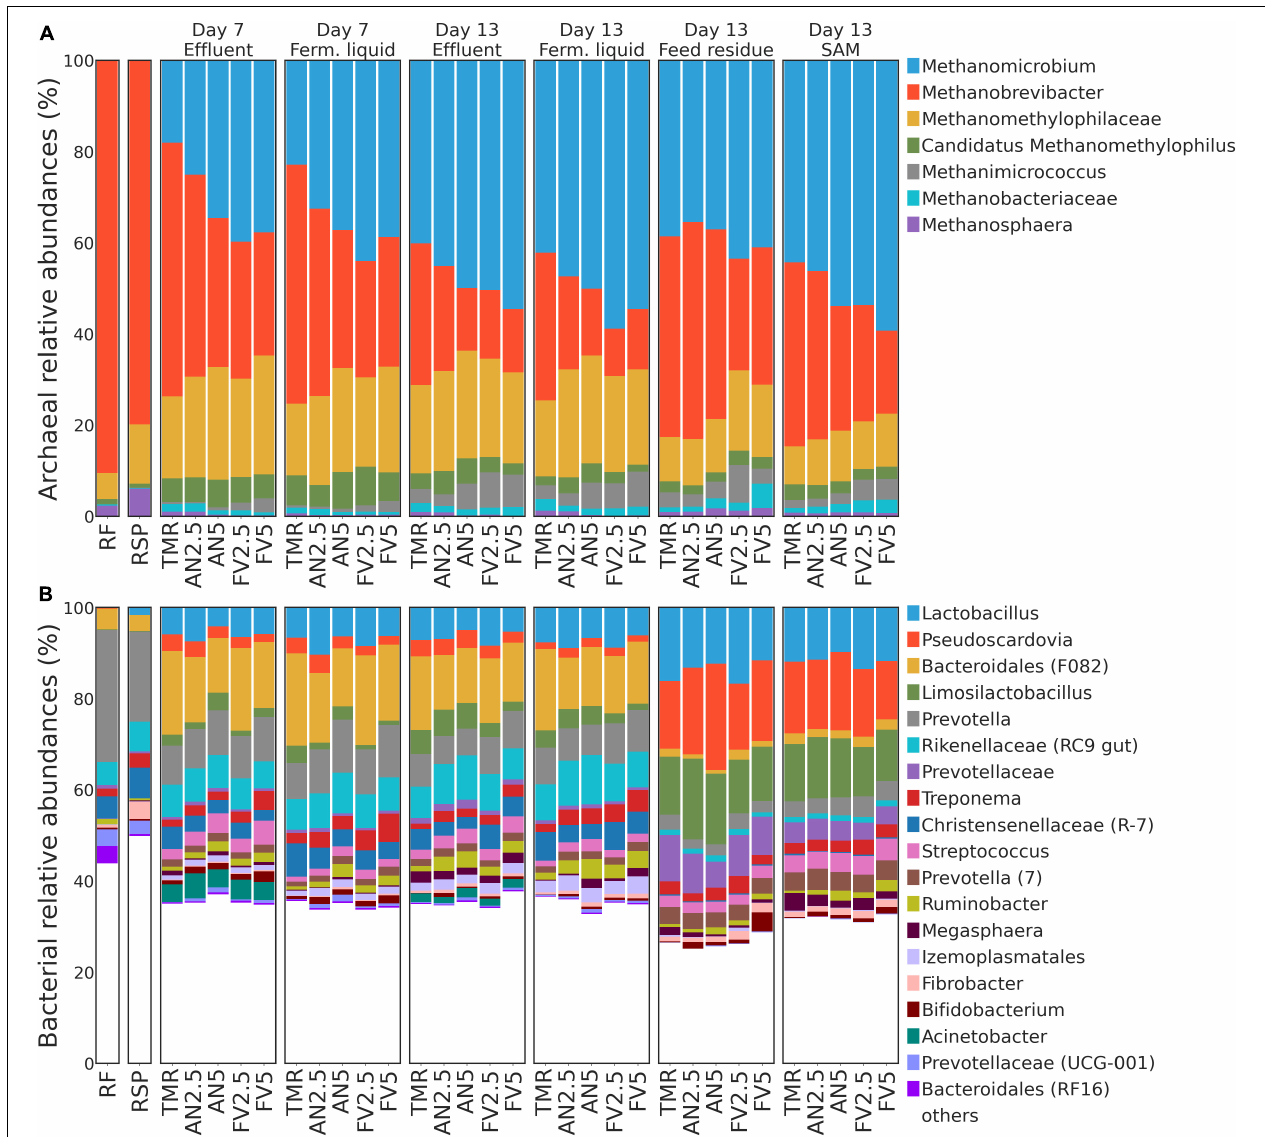
FIGURE 5 | Stacked taxonomy bar plots. Relative abundances of (A) archaeal and (B) bacterial genera are plotted for each sample type and sampling day by treatments (only genera with relative abundance ≥ 3.5% among at least one column were included). If certain features were not annotated to genus level, the last available taxonomy unit was shown. Minor Silva annotation identifiers, such as clades, taxonomic groups, clones, and others not included in commonly used nomenclature, are indicated in the round